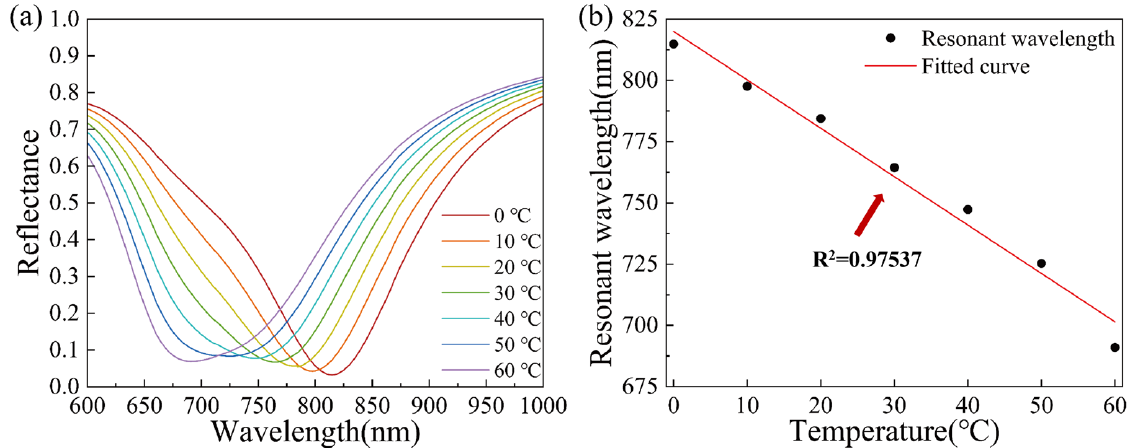
Figure 6. ( a ) The reflectance curve of the proposed 160 nm TiO 2 -45 nm Au SPR sensor in the range of 10–60 °C and ( b ) SPR wavelength corresponding to temperature of the proposed 160 nm TiO 2 -45 nm Au SPR sensor and linear fitting.